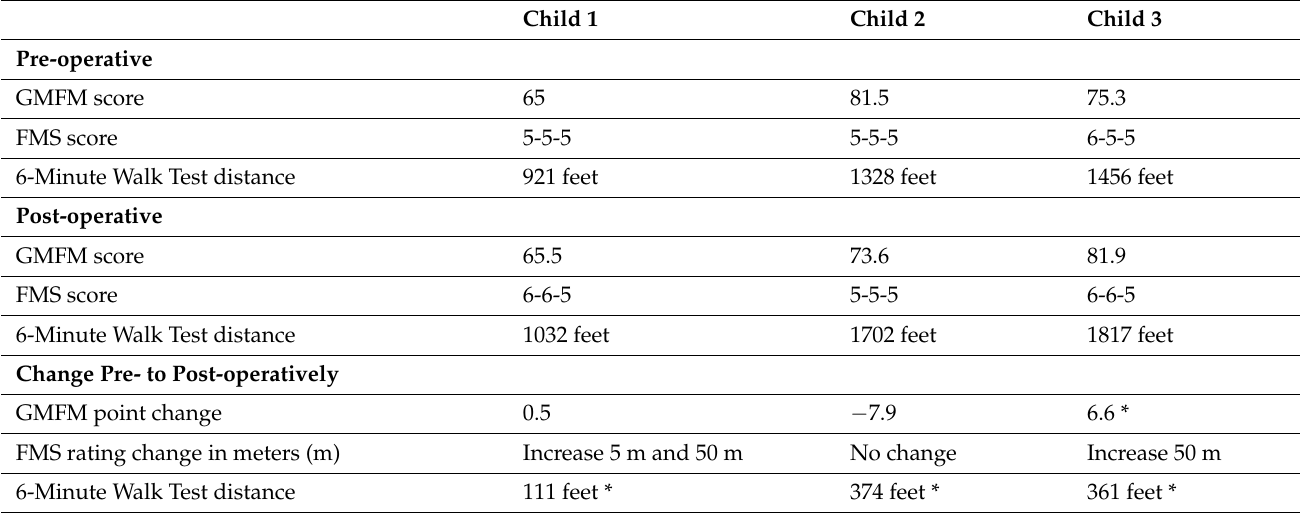
Table 3. Pre- and post-operative outcome measures following NMES intervention in children undergoing lower extremity orthopaedic